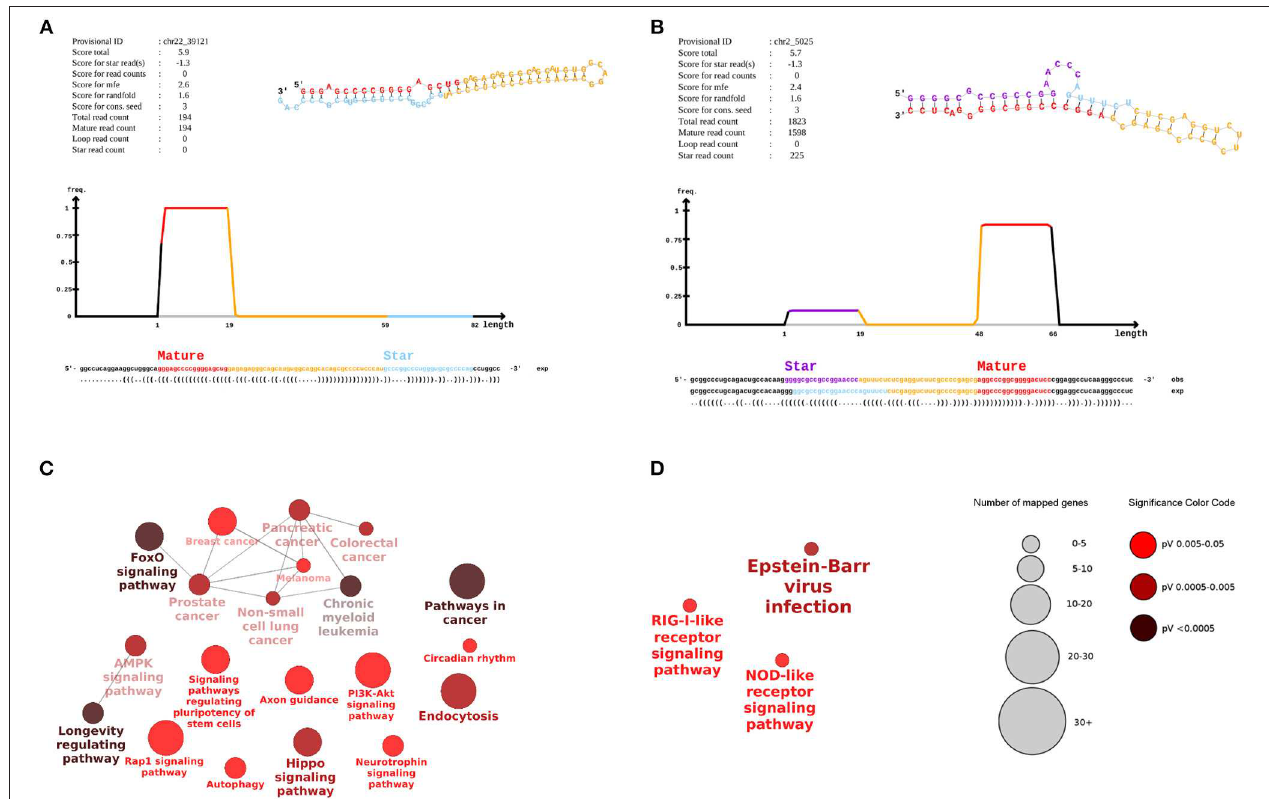
FIGURE 2 | Novel miRNAs in human breast milk-derived exosomes and pathways associated with differentially expressed miRNAs. The (A,B) displays signature and structure of two novel miRNAs. (A) provisional ID: chr22_39121, located in an intron of SUN2 (B) provisional ID: ch2_5025, mapped to a conserved intergenic region. The upper right figure shows the predicted RNA secondary structure of the hairpin, partitioned according to miRNA biogenesis: red, mature; yellow, loop; purple, star. The middle density plot shows the distribution of reads in the predicted precursor sequence. The sequences below indicate the positions of the mature, loop, and star strand. The positions of the star strand as expected from Drosha/Dicer processing is shown in light blue, while the star consensus positions as observed from the sequencing data is shown in purple. The (C,D) display a network of enriched pathways associated with targets of (C) upregulated and (D) downregulated miRNAs. The size and color of the nodes is proportional to the number of mapped genes and p -value significance of a given